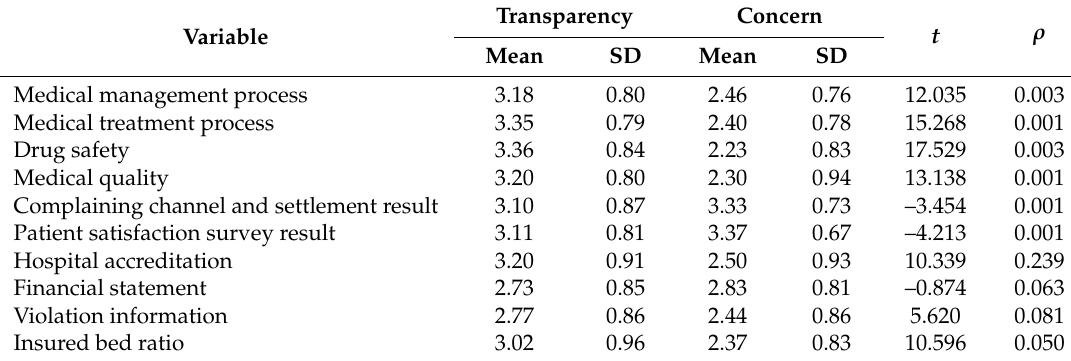
Table 4. Analysis of transparency of mandatory information disclosure and concerns of health service consumers ( n = 384).